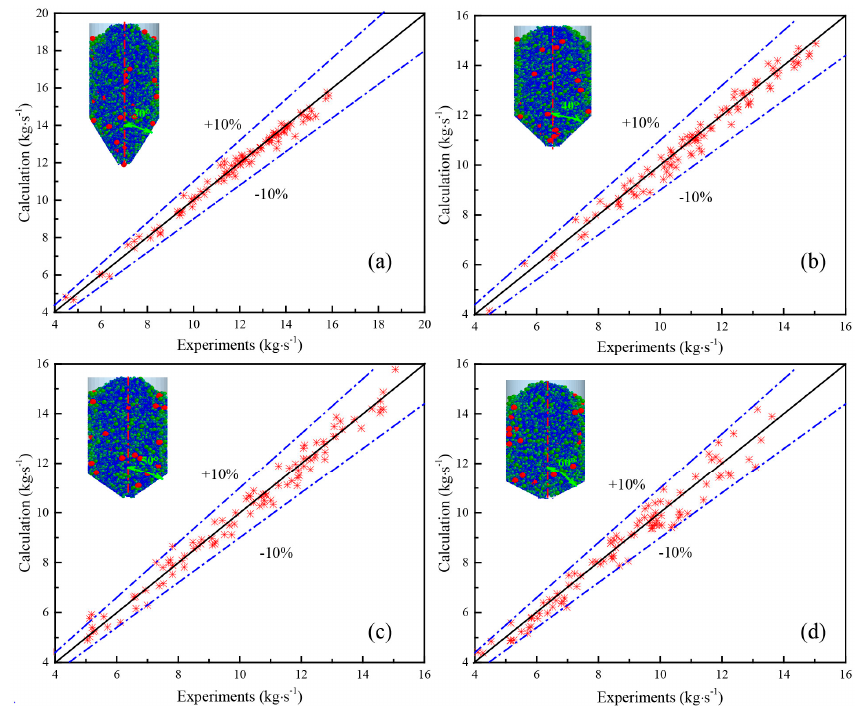
Figure 3. The deviation of the calculation and experimental value with different hopper half angles of ( a ) 30°, ( b ) 40°, ( c ) 50°, and ( d ) 60° using the Equation (3).